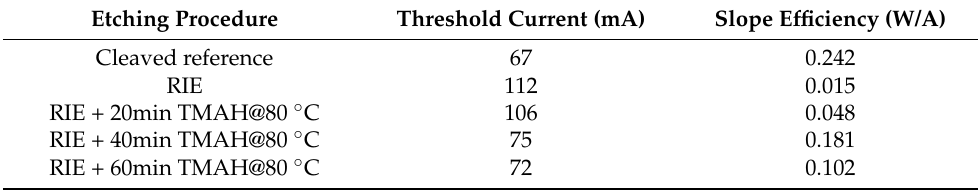
Table 1. Lasing parameters of etched facet laser